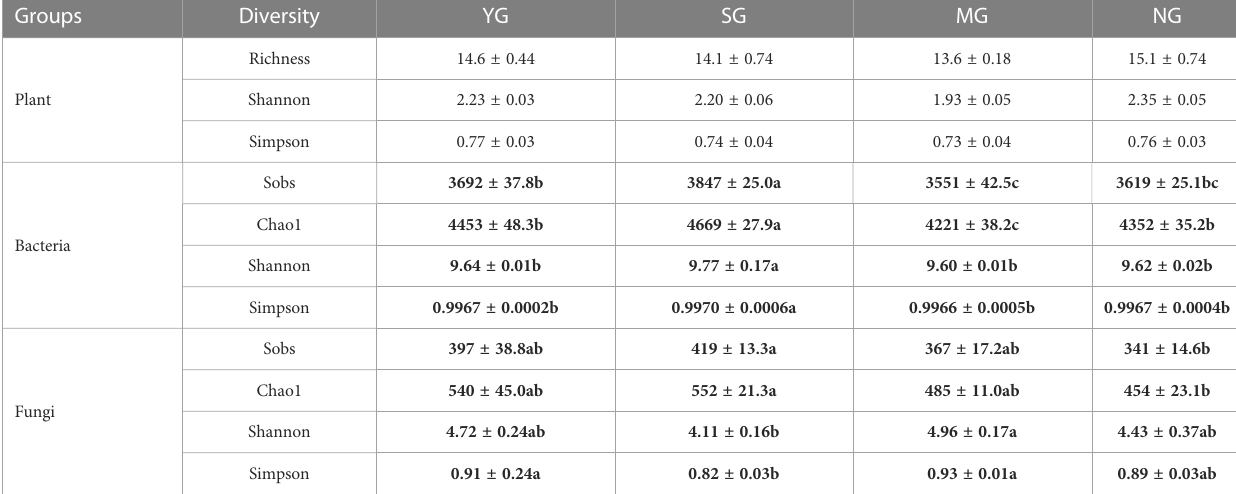
TABLE 2 a -diversity of plant, bacterial and fungal communities under different herbivore assemblages. Groups